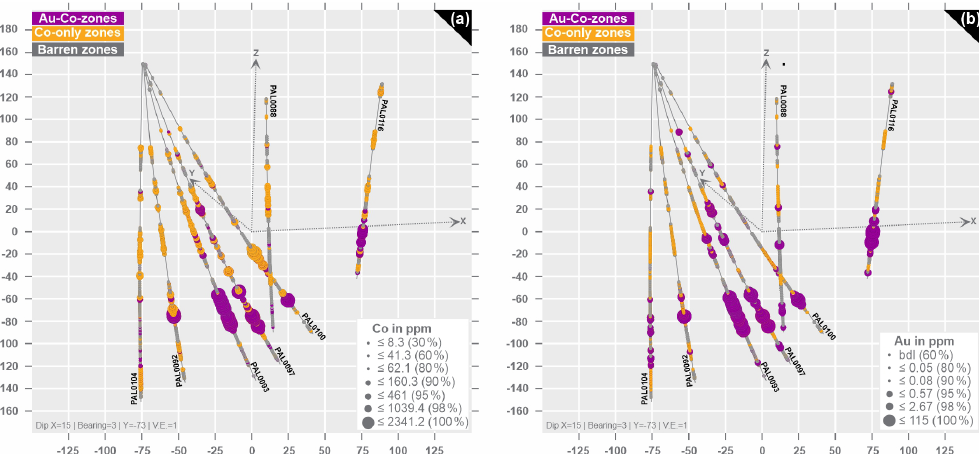
Figure 6. 3D model of sampled drill cores showing the distribution of gold and cobalt. Ore zones are characterized as (a) Co-only zones (orange), where Au is b.d.l. and as (b) Au–Co zones (purple), with Au up to 115ppm and Co up to 2341ppm. Barren zones are indicated in grey colors.